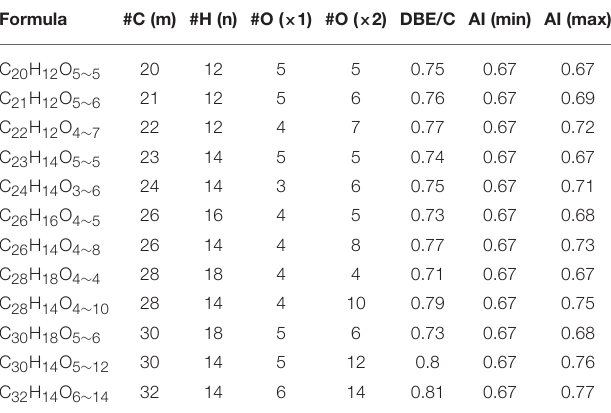
TABLE 1 | Empirical DBC molecular formulae selected for K ow modeling.